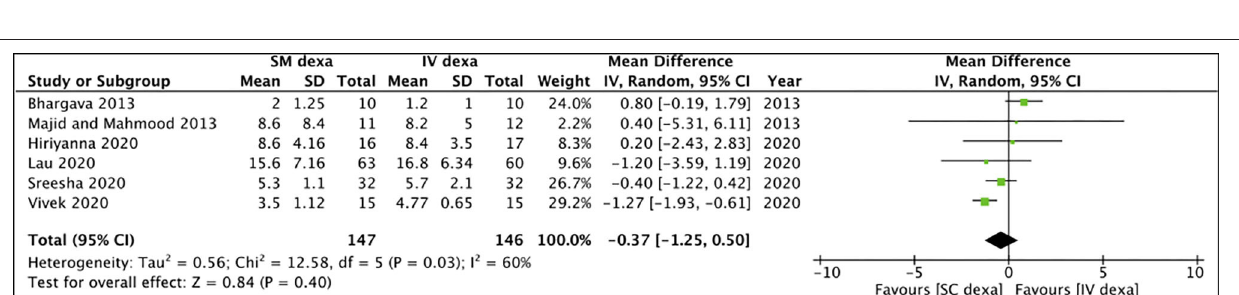
GRADE assessment of evidence for SM vs. IM dexamethasone